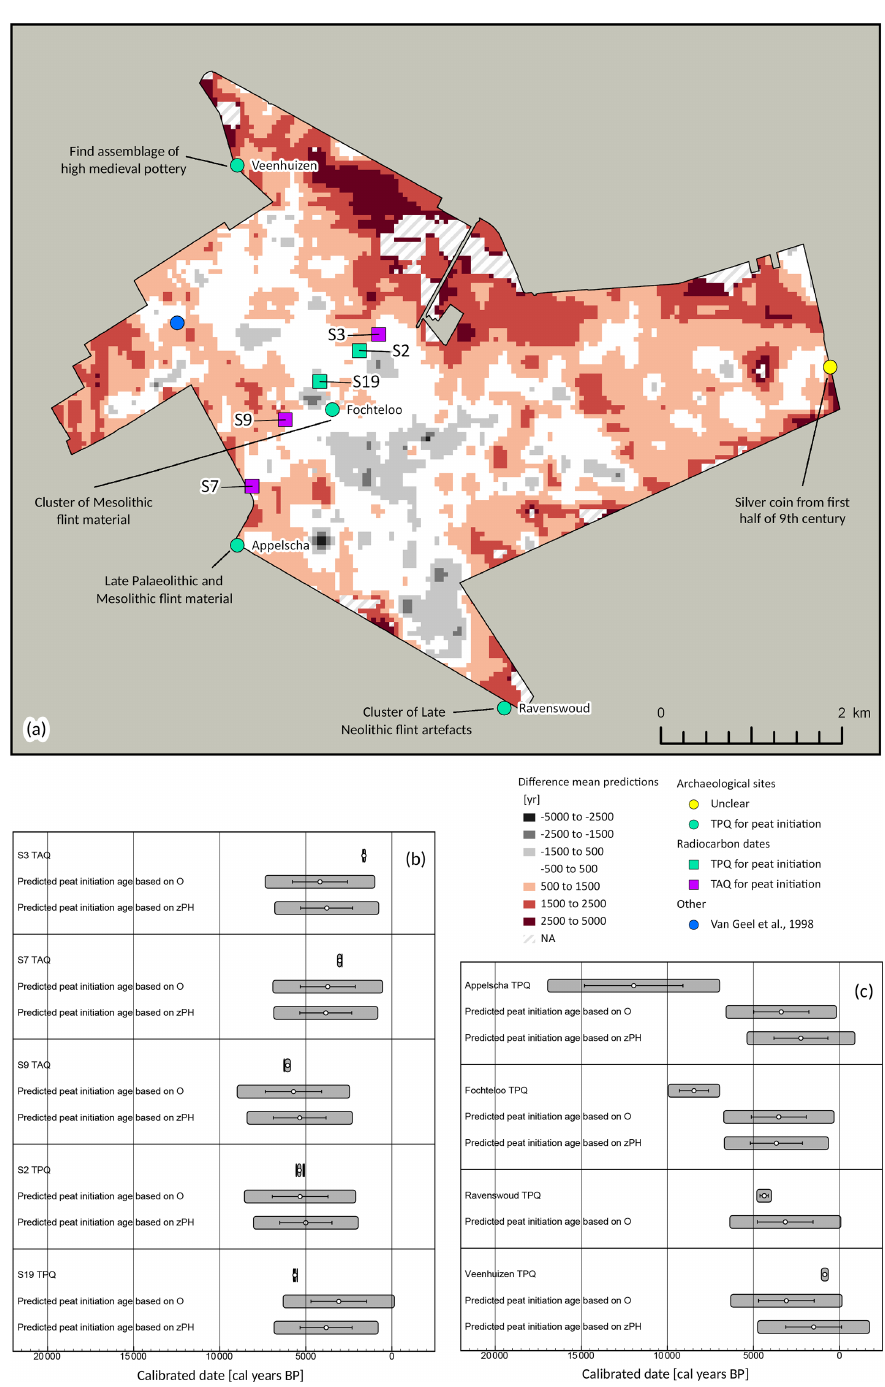
Figure 9. (a) Difference between the mean predictions of peat initiation age in Fig. 8a and b (i.e. prediction of Fig. 8a minus prediction of Fig. 8b). The locations of the validation points (of which results are presented in b and c ) are also indicated on this map (for further details on the archaeological sites, see Table 2). In (b) and (c) validation points are compared with the predicted peat initiation age as predicted by both covariates (i.e. each validation point is compared with the prediction of Fig. 8a and with the prediction of Fig. 8b). The central circles show the mean, bars indicate 1 σ confidence interval, and grey-coloured blocks indicate the 2 σ confidence interval. Note that terminus-ante- quem validation points should be older than the prediction, whereas terminus-post-quem validation points should be younger (see Sect. 4.2). (b) Validation points consisting of radiocarbon dates of peat samples that indicate a terminus ante quem ( n = 3) and terminus post quem ( n = 2) for peat initiation. (c) Validation points consisting of archaeological sites that indicate a terminus post quem for peat initiation ( n = 4; for one archaeological site the relationship with peat growth is unclear; therefore, this site was not included here; see Table 2 for